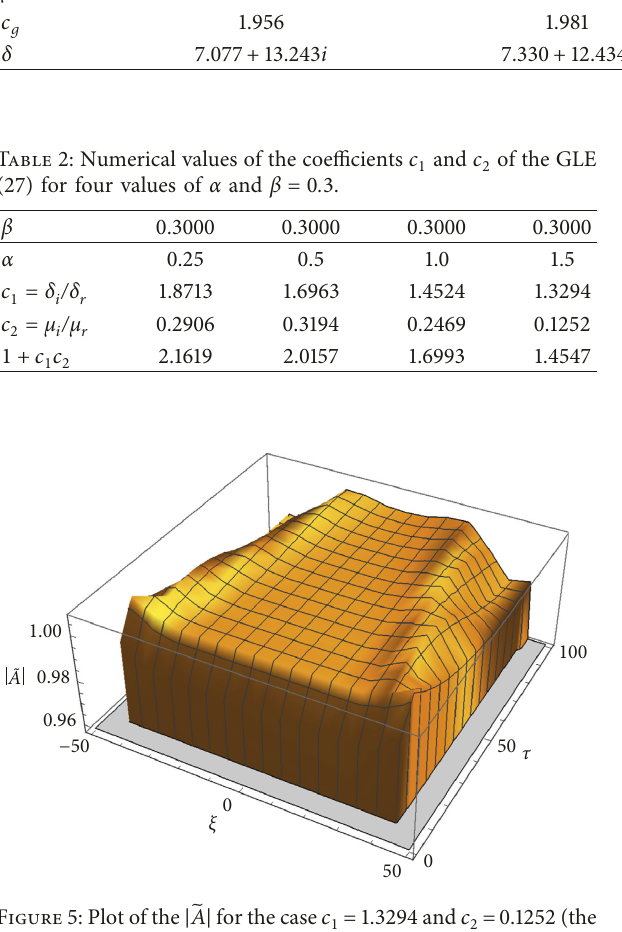
� 1.3294 and c � 0.1252 (the 1 2